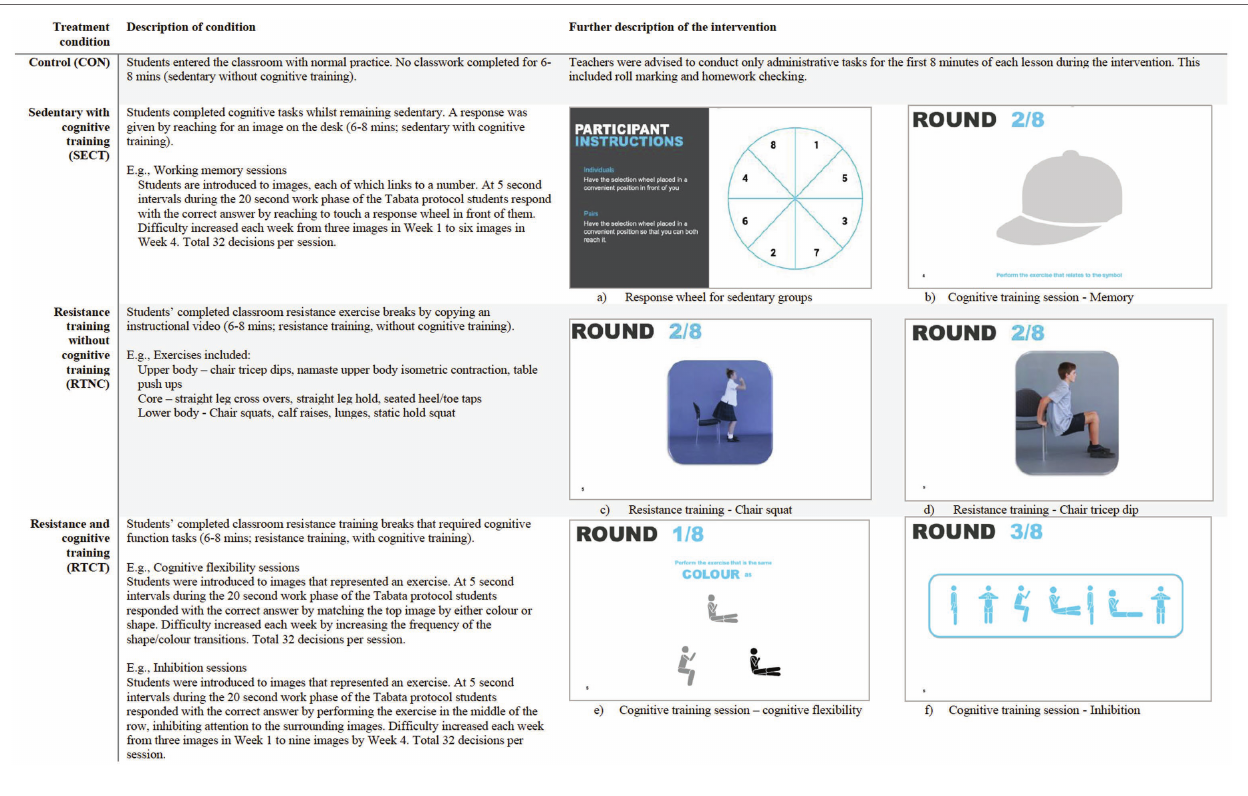
FIGURE 2 | Outline of intervention group